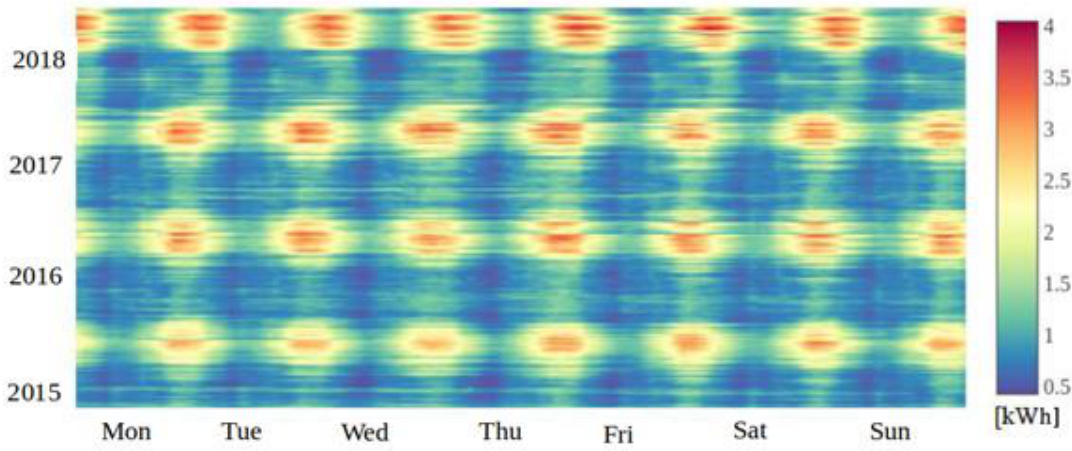
Figure 3. Heatmap of average EE consumption in a week.